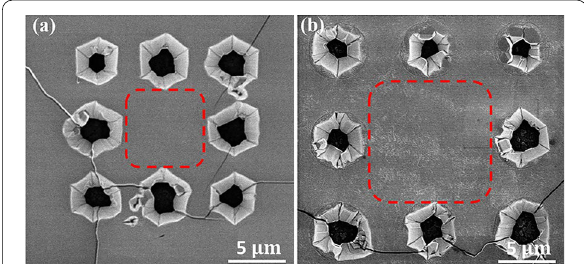
Fig. 2 SEM images of (Al)GaN epi-layers on the suspended thin-film substrate with the adjacent hole spacing being a 6 µ m , b 8 µ m . The effectively suspended zones are indicated by the red dashed-line squares, which show intact and continuous film quality